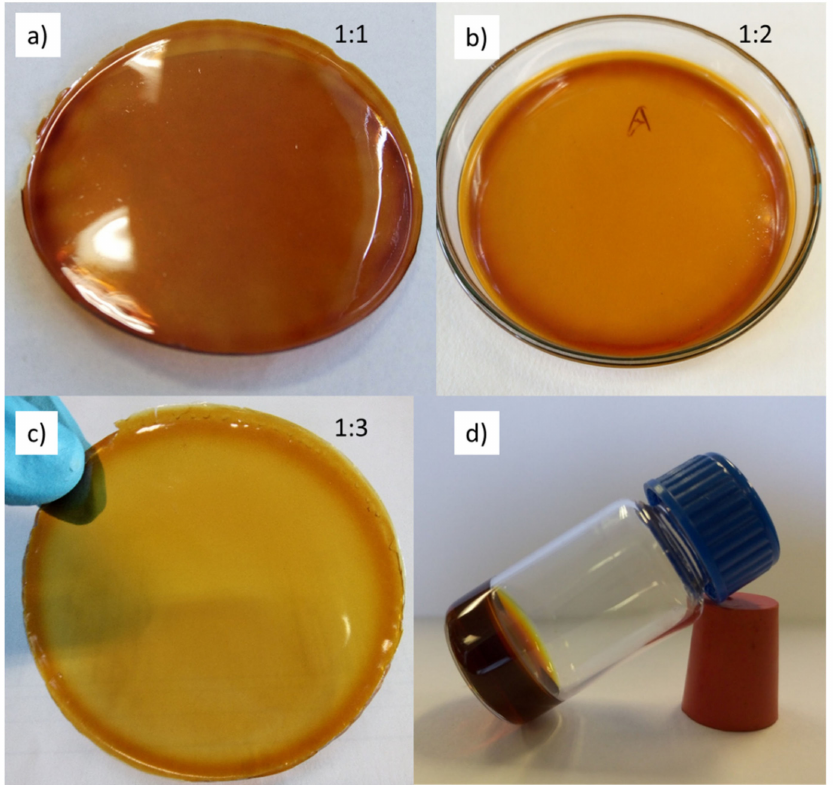
Figure 1. Aspect of PBI-c-PVBC membranes after 24 h of crosslinking with molar ratios ( a ) 1:1, ( b ) 1:2 and ( c ) 1:3. ( d ) Gelated mixture after 72 h of crosslinking at 80 ◦